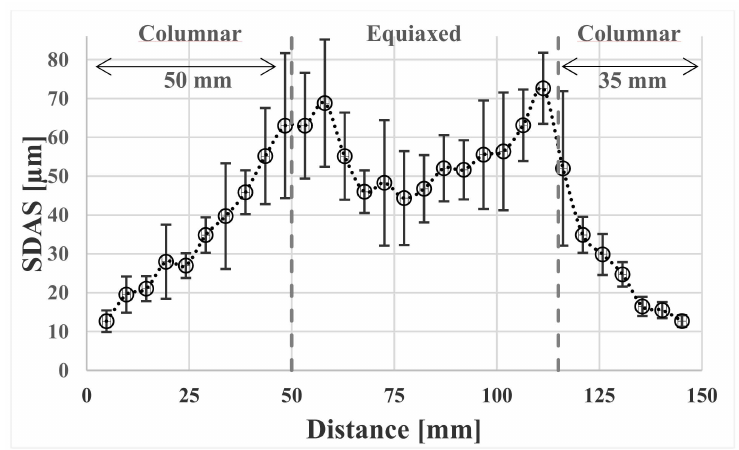
Figure 6. Secondary dendrite arm spacing with standard deviation measured on the cross section over the billet.